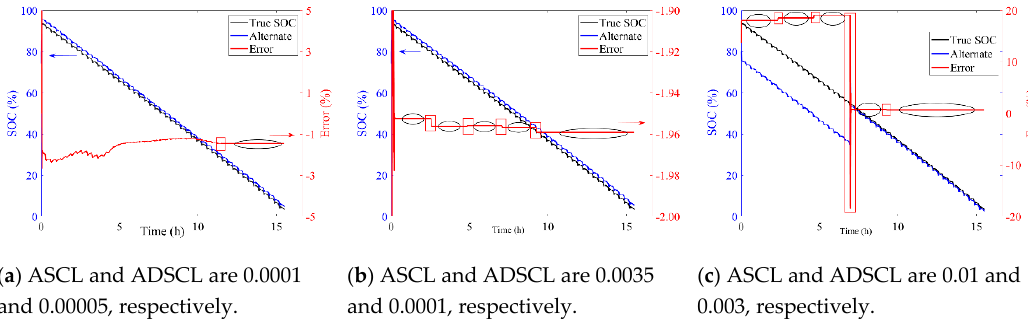
Figure 8. SOC estimation process and errors using alternate method with ASCL and ADSCL of different values.